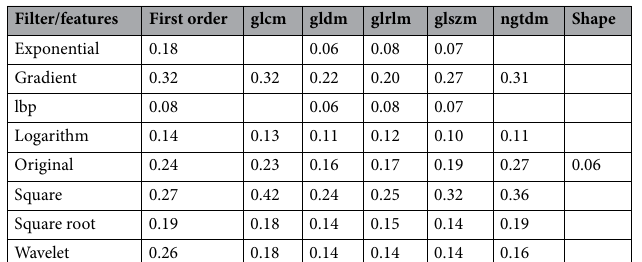
Filter/features